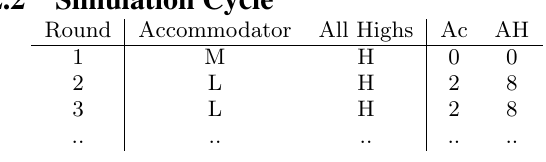
Table 2: Accommodator meets All